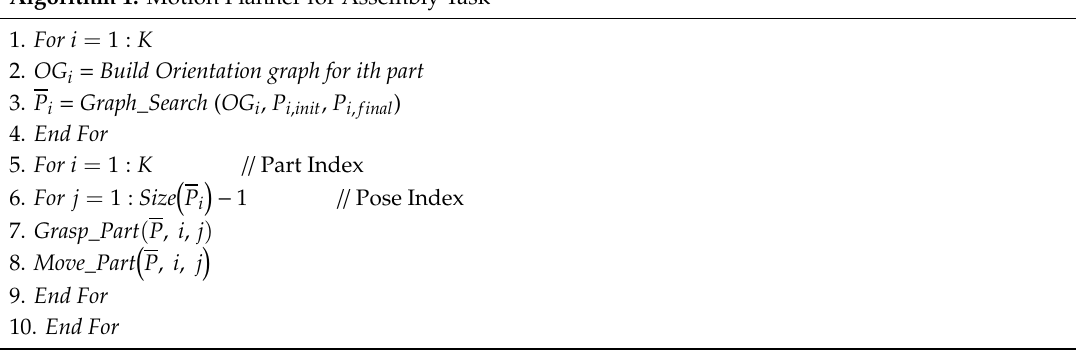
Algorithm 1. Motion Planner for Assembly